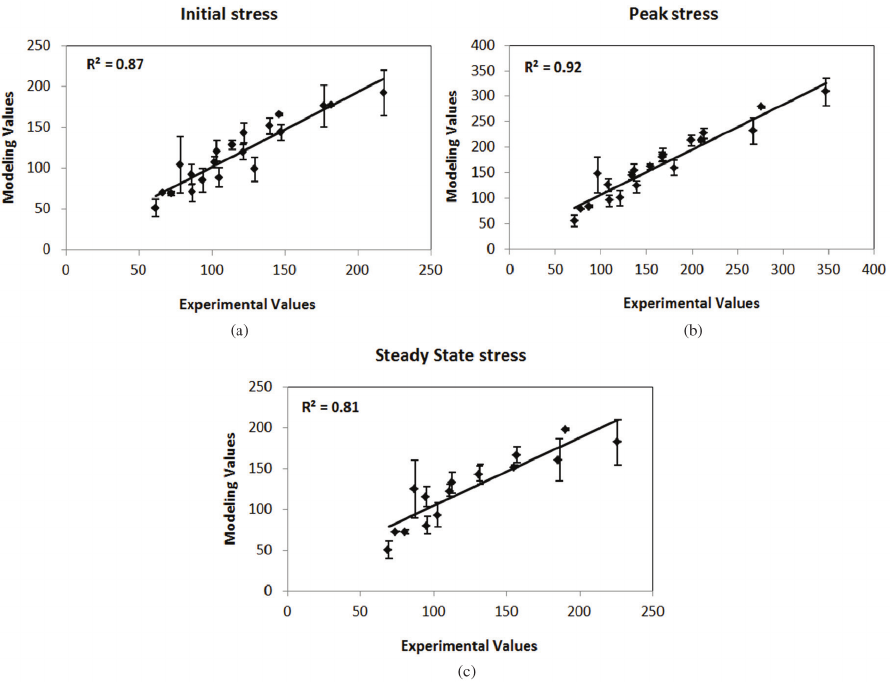
Figure 7. Correlation between experimental and modeled main points of flow curves of the austenitic stainless steel ISO 5832-9: (a) initial stress ( σ ), (b) peak stress ( σ ), (c) steady state stress ( σ o p ss